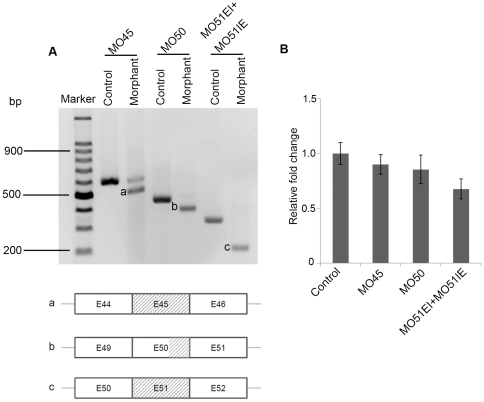
The splicing of lrrk2 mRNA was interrupted by the morpholino oligos.The injection dose of the morpholino oligos was 8 ng each per embryo. A, RT-PCR with cDNA of 3 dpf embryos (control and morphant) confirmed the blockage of normal splicing. The aberrant splice products (band a, b and c in A) were cloned and sequenced.The slash lines indicate the deletion of exons. All of the aberrant mRNA variants have reading frame shifts and pre-mature stop codons, and produce putative truncated LRRK2 proteins in the corresponding domains shown in Figure 1. In the lanes of MO50 morphant and MO51EI+MO51IE morphant, almost no wild type LRRK2 mRNA was present. B, qPCR using primers flanking the region upstream to MO target sites shows at least 60% LRRK2 transcripts can be detected, indicating no obvious nonsense mediated decay of LRRK2. Data were shown as mean±S.E.M of biological triplicates from at least two independent experiments and were presented as fold changes in relative gene expression as compared with control after being normalized to beta-actin. The relative fold changes were calculated by a comparative Ct method. P>>0.05 between control, MO45, and MO50 group; P < 0.05 between control and MO51EI+MO51IE group.